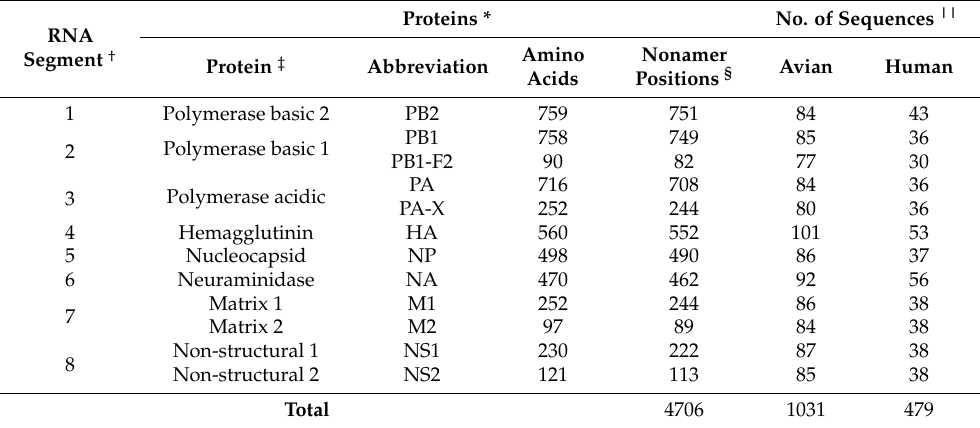
Table 1. Influenza A (H7N9) protein sequences analyzed from the 2014 dataset. The individual protein sequences of the 1031 avian viruses ranged from 77 PB1-F2 to 101 HA, and those of the 479 human virus sequences ranged from 30 PB1-F2 to 56 NA.